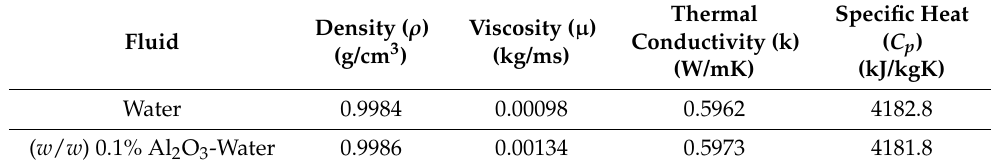
Table 3. Base fluid and nanofluid thermophysical properties. Fluid